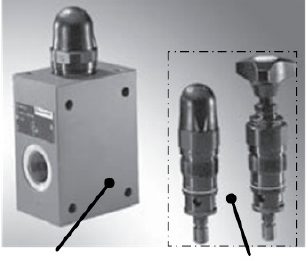
Figure 3. The DBD type relief valve.